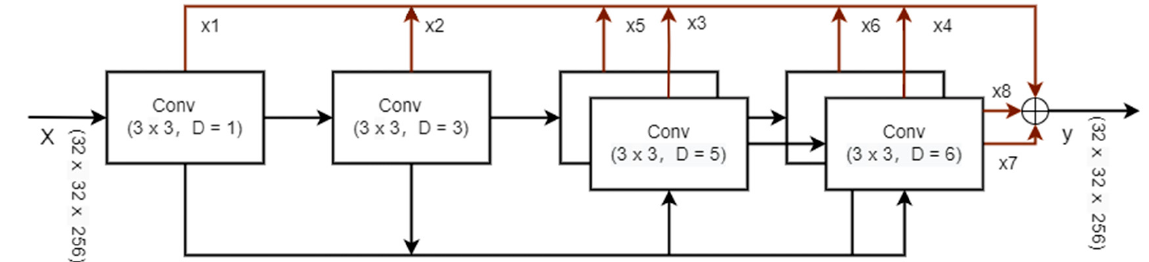
Figure 2. A schematic of the multi-path dilated convolution architecture.